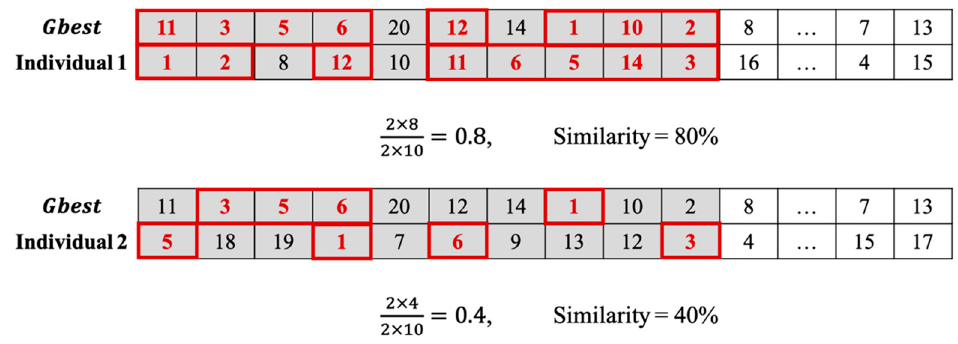
Figure 15. Set similarity metric